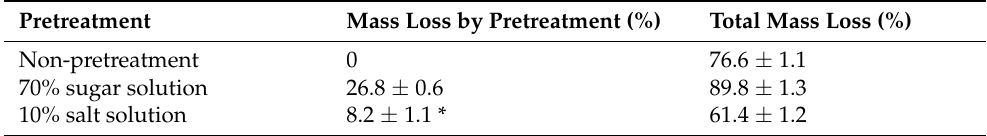
Table 1. Mass loss of jaboticaba berries pretreated with 70% sugar and 10% salt solutions. Pretreatment Non-pretreatment